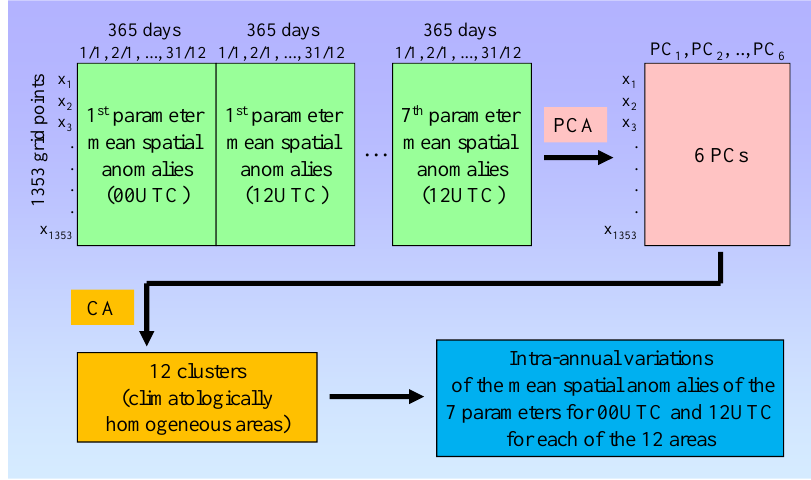
Figure 2. The methodology scheme used in the present study.